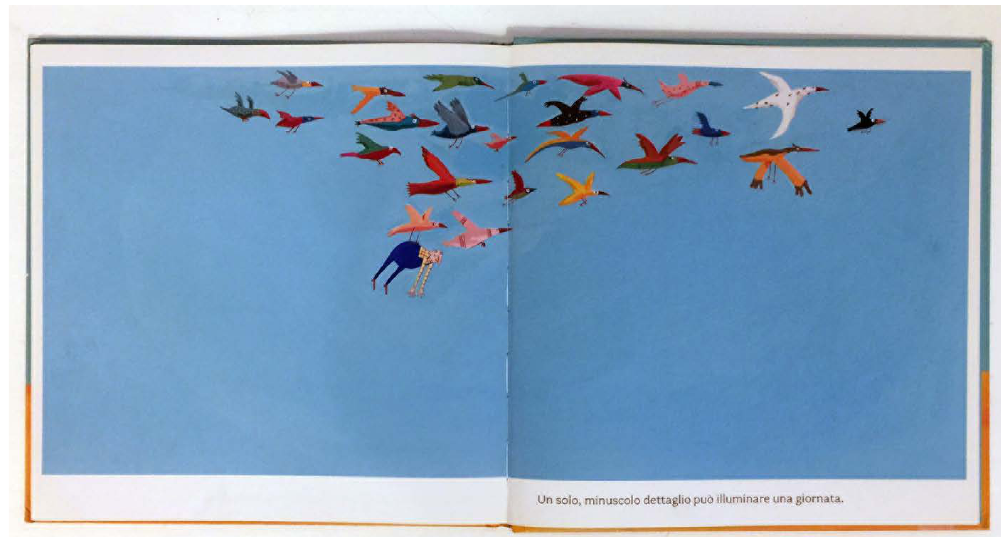
Fig. 14 Germano Zullo and Albertine, Gli uccelli ,